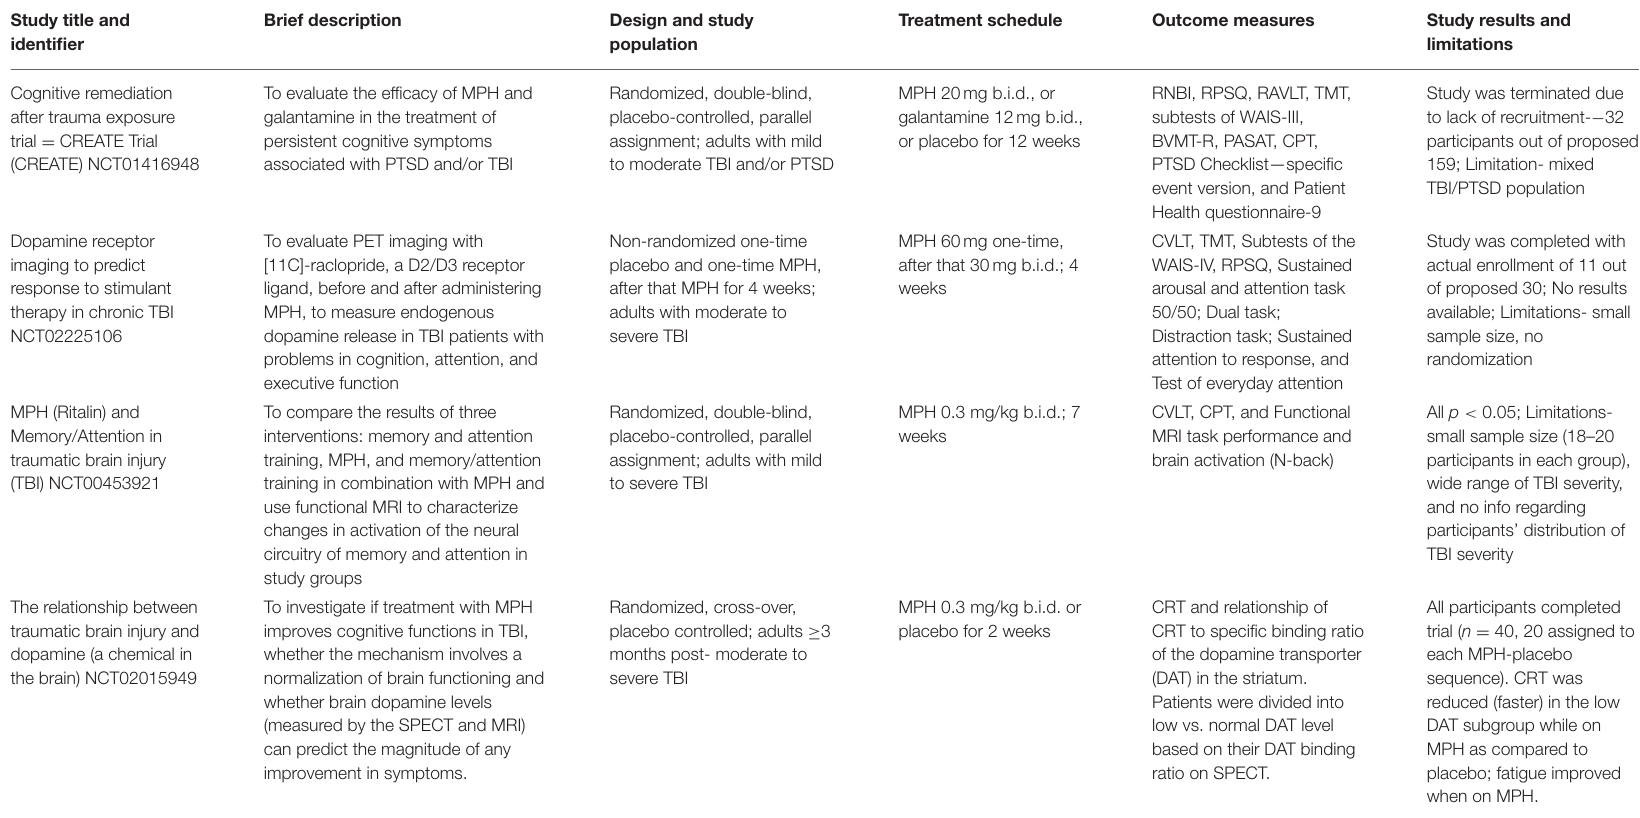
TABLE 1 | MPH interventions in adults with a history of TBI ranging from mild to severe (see